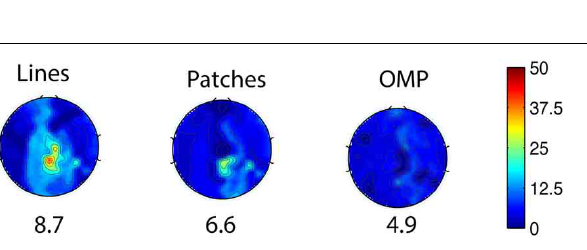
over 500 realizations is 5.65% with a maximum error at